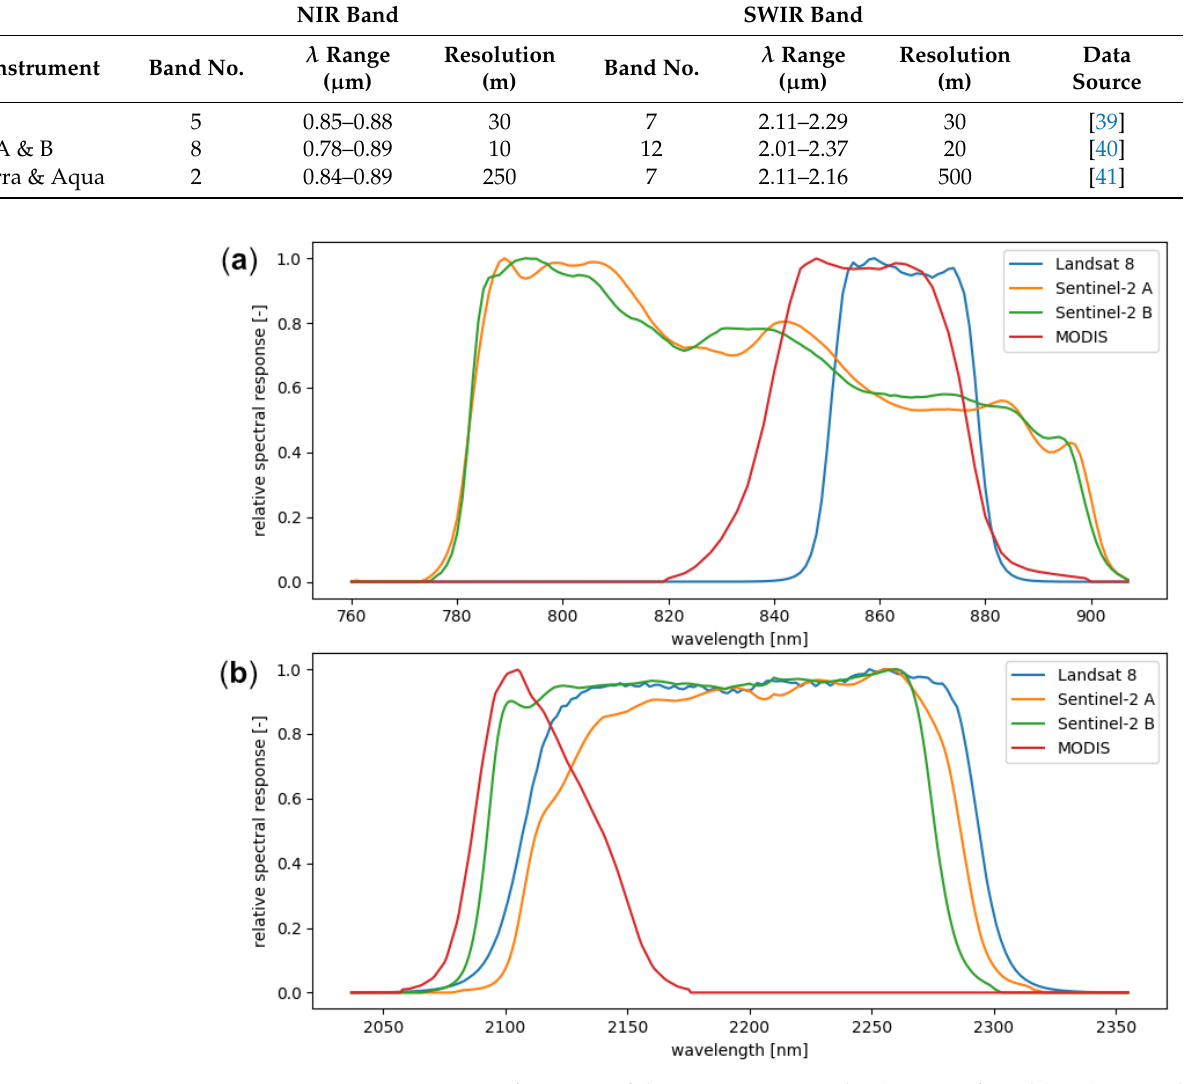
Figure 2. Instrument response functions of the instruments used: ( a ) Near-infrared (NIR) spectral bands. ( b ) Shortwave infrared (SWIR) spectral bands. The spectral response of the Sentinel-2 A and B instruments are slightly different, whereas the responses of the two Moderate Resolution Imaging Spectroradiometer instruments (MODIS Terra and Aqua) are